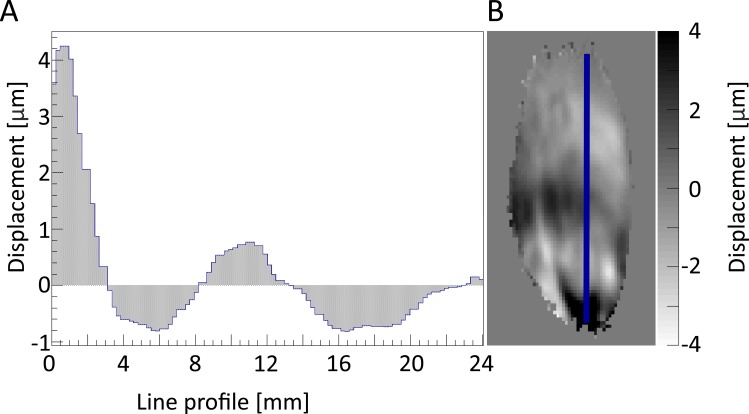
Displacement field of z-direction with line profile.(A) Shows the displacement in μm along the line profile illustrated as blue line in the (B) displacement field image of the z direction in the TA muscle.